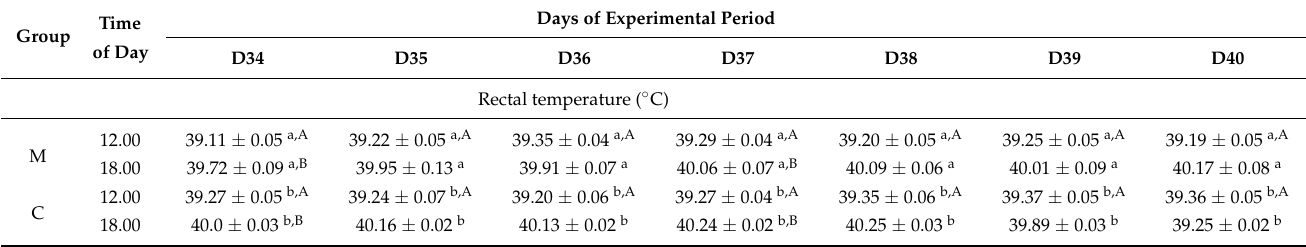
Table 1. Rectal temperature and breathing rate (mean ± SEM) in group M (melatonin) and group C (control) during the week following the introduction of rams into the ewe flock